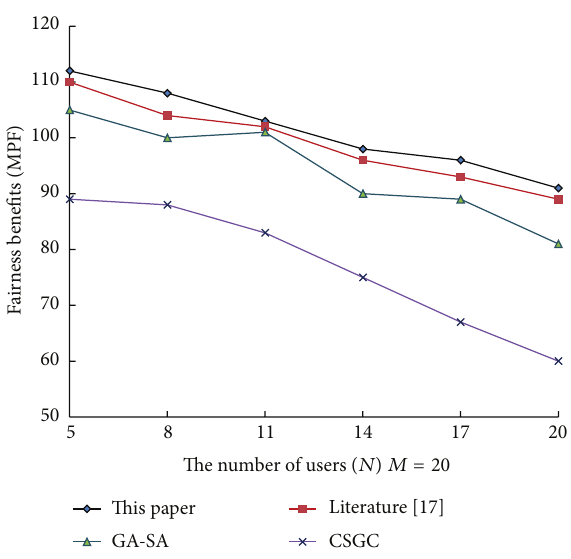
Figure 4: Influence of number of cognitive users on MSRM.